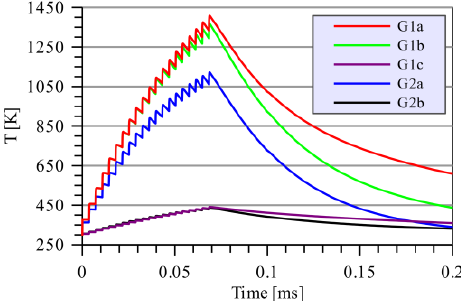
Figure 8. Time dependence of maximum MLL temperature for different geometries of WC/SiC MLLs.